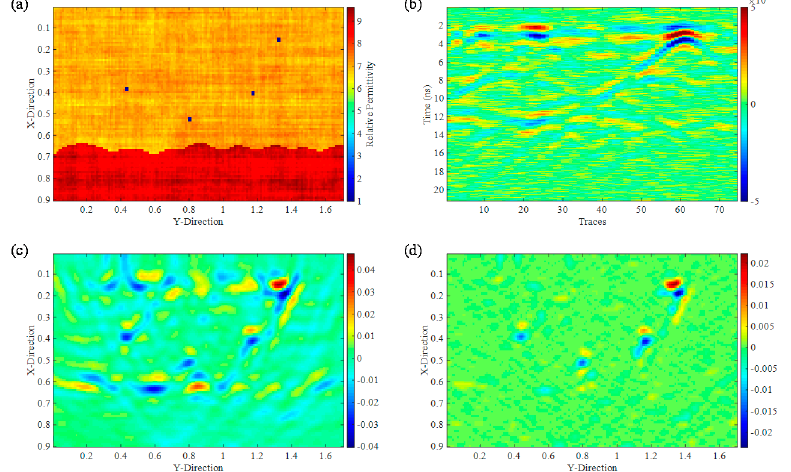
Figure 3. The water-free seepage channel model. ( a ) the distribution of relative permittivity; ( b ) 2- D GPR profile; ( c ) back projection imaging; ( d ) RPCA anomaly extraction. GPR profile; ( c ) back projection imaging; ( d ) RPCA anomaly